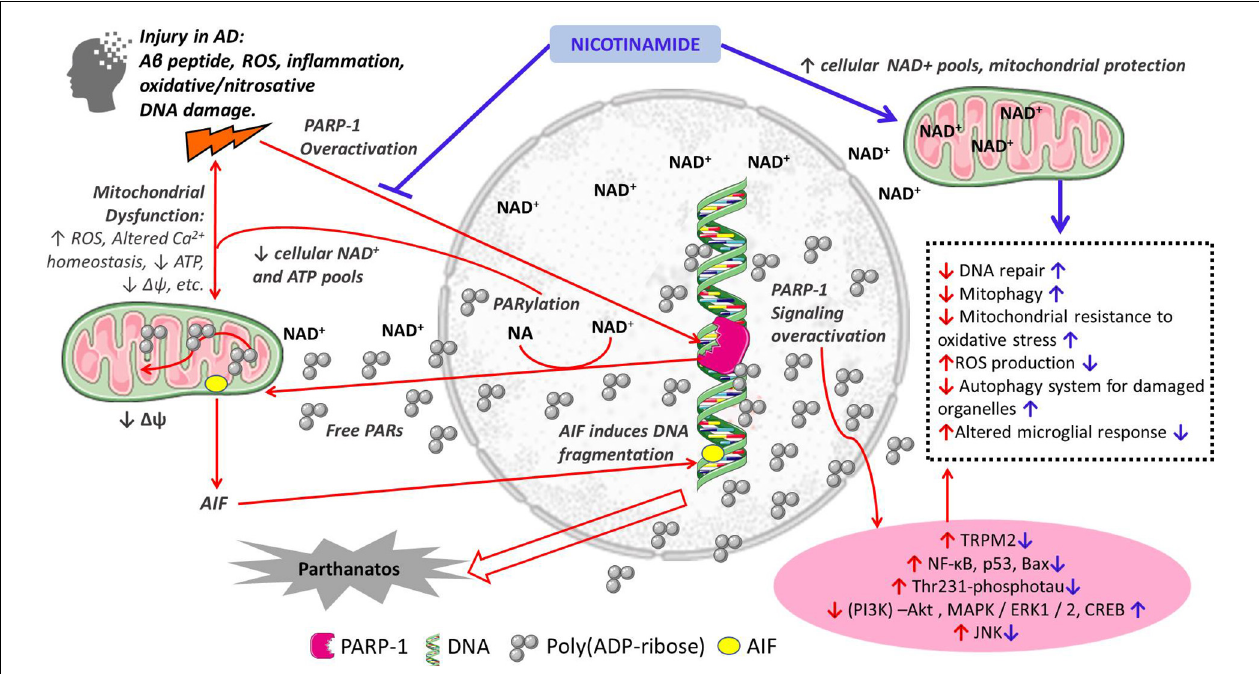
FIGURE 1 | Schematic representation of the proposed mechanisms of action of nicotinamide in the pathogenesis of Alzheimer’s disease. Red arrows indicate mechanisms of cellular damage in AD: pro-death, mitochondrial dysfunction and inflammation; Blue arrows indicate protective effects of nicotinamide directly as a substrate for NAD + synthesis with its effects on cellular metabolism, and through PARP-1 inhibition and its beneficial effects preventing cell death, mitochondrial dysfunction and inflammation. Other PARP-1 inhibitors may have similar effects.